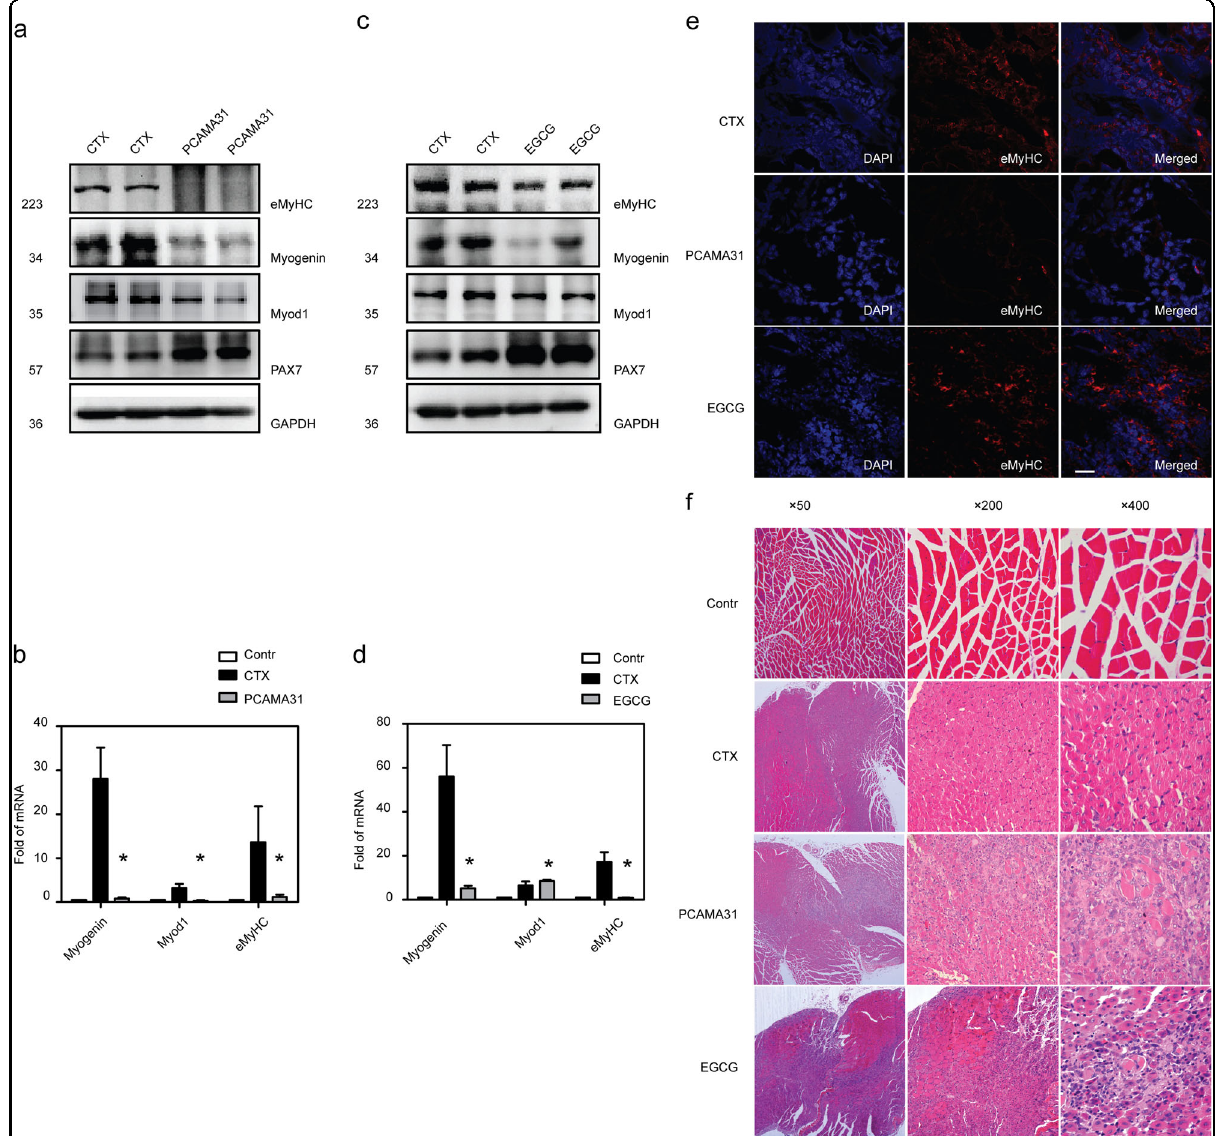
Fig. 3 Inhibition of PDIA3 impaired muscle regeneration. The gastrocnemius was injured by the direct injection of 100 µl CTX (10 µM) and treated with PCAMA31 or EGCG. The gastrocnemius was collected 3 days after injury. a The levels of Pax7, Myod1, myogenin, and eMyHC in gastrocnemius muscle treated with PCAMA31 were analyzed by immunoblotting ( n = 4). b The mRNA levels of Myod1, myogenin, and eMyHC in gastrocnemius muscle treated with PCAMA31 were tested by q-PCR (* P < 0.05 vs. Control; n = 4). c The levels of Pax7, Myod1, myogenin, and eMyHC in gastrocnemius muscle treated with EGCG were analyzed by immunoblotting ( n = 4). d The mRNA levels of Myod1, myogenin, and eMyHC in gastrocnemius muscle treated with EGCG were tested by q-PCR (* P < 0.05 vs. Control; n = 4). e Frozen sections of gastrocnemius muscle were subjected to the immuno fl uorescence staining of eMyHC. The cell nuclei were stained with DAPI. The gastrocnemius was injured by the direct injection of 100 µl CTX (10 µM) and treated with PCAMA31 or EGCG. Scale 100 µm. f The gastrocnemius was collected 14 days after injury, and paraf fi n-embedded muscle sections were subjected to H&E